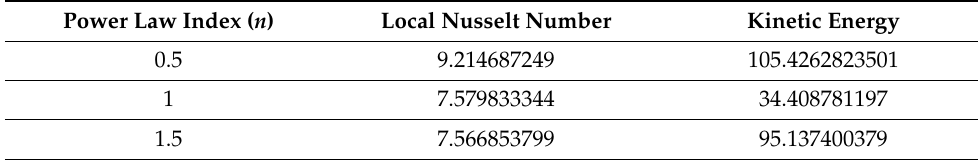
Figure 4. Variation in Local Nusselt number against ( n ) at X = 0.5. Table 3. Variation of Nusselt Number and Kinetic Energy with power-law index ( n